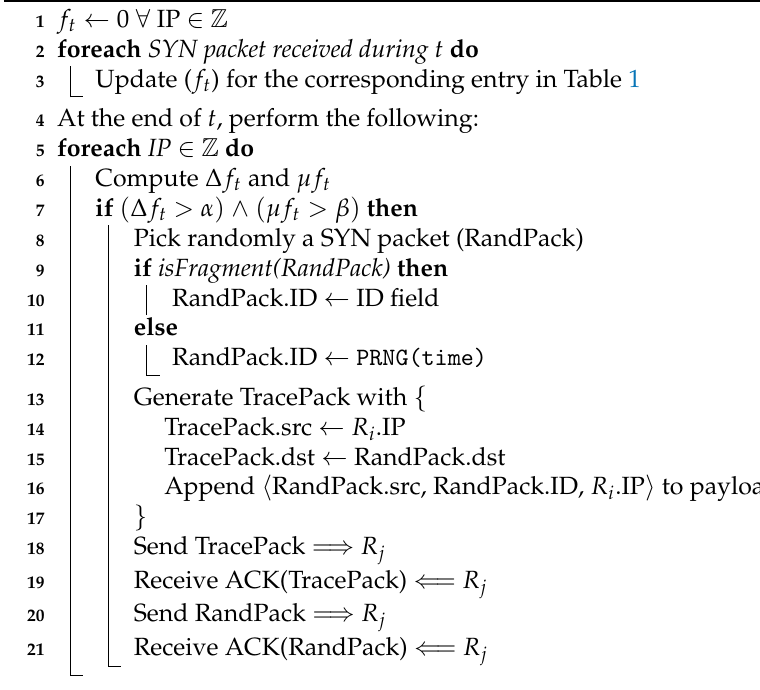
Algorithm 1: Pseudo code for the RAPT algorithm at the edge router.